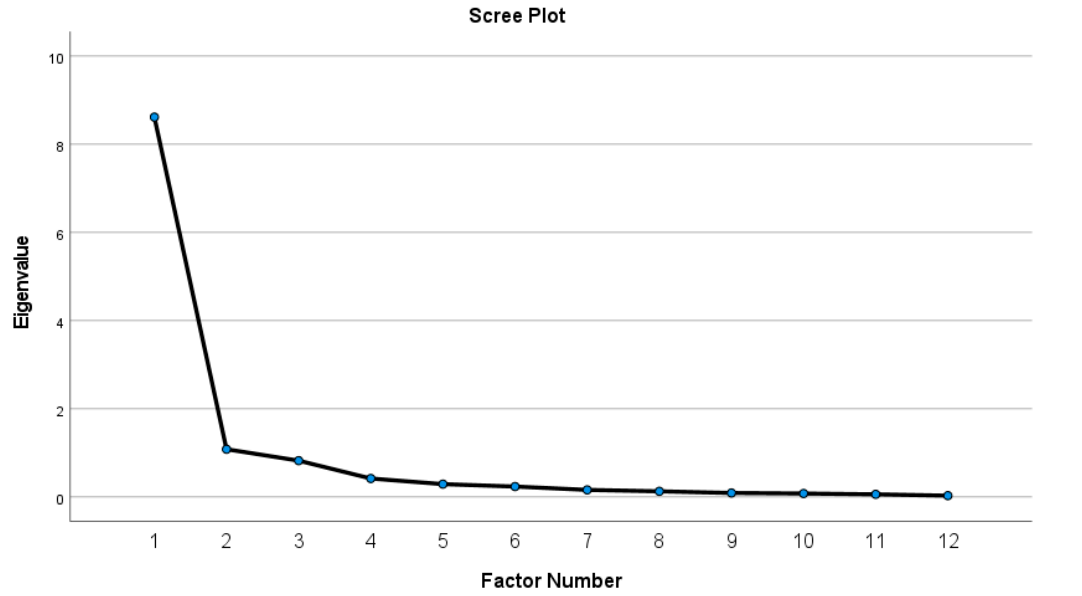
The importance of water management and conservation competencies were analyzed Proficiencies of integrated pest management competencies were analyzed using a using a factor matrix. Factor one consisted of five items with factor loadings ranging from factor matrix. Factor one consisted of twelve items with factor loadings ranging from 0.75